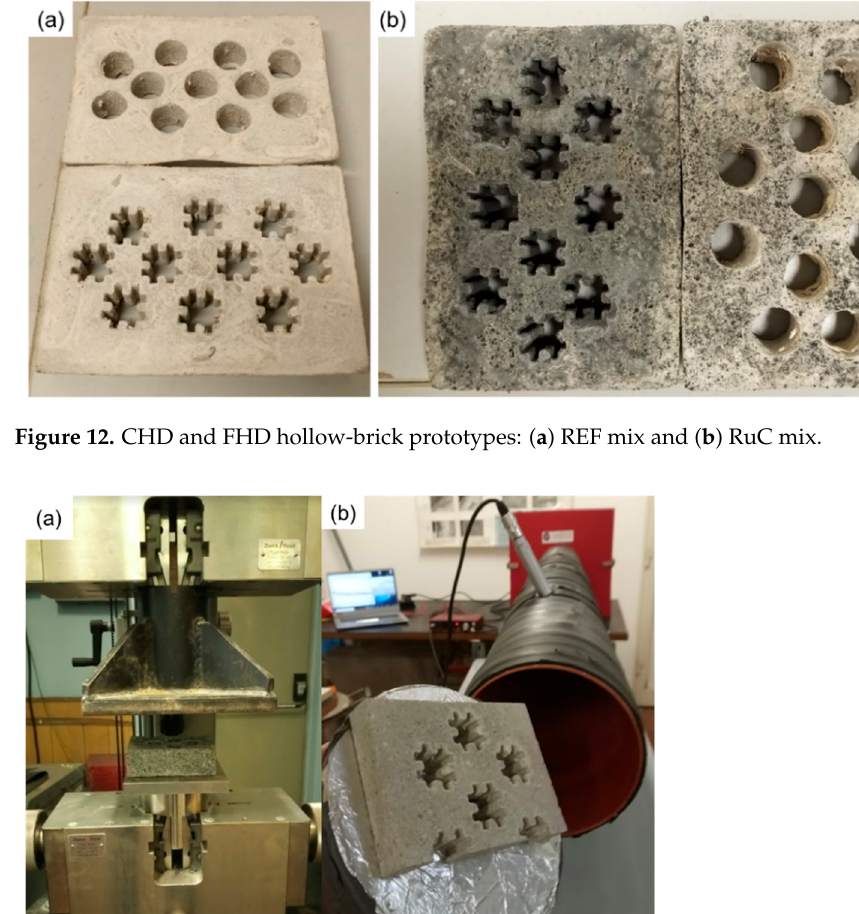
14 of 24 Figure 10 . CNC cutting operation: ( a ) end mill, ( b ) array of fractal designs after cutting, and extrac- tion of the ( c ) fractal and ( d ) circular columns. The correct alignment of the columns on the mold’s base was made possible through the fabrication of masks that exactly reproduced the hollow surface of the designed bricks. Tailored cardboard masks (Figure 10a) were produced by high-precision laser-cutting technology (Figure 10b), using a Birio 1000 laser cutter (Birio, Naples, Italy). After posi- tioning and gluing the columns, we removed the guide-masks were, and the mold was left to settle to allow the complete fixing of the columns on the vessel’s base The completed and ready-to-use brick molds (FHD and CHD configurations) are illustrated in Figure 11c,d, respectively. Figure 11. ( a ) Laser cutting of the guide-masks, ( b ) CHD and FHD guide masks, and ( c ) mold brick for FHD and CHD design. 2.3.2. Casting and Bricks Manufacturing